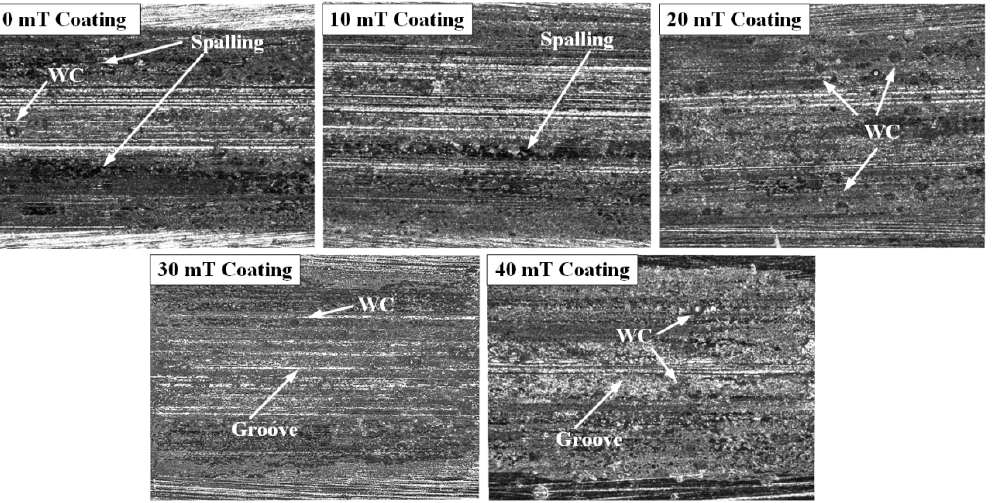
Figure 6. The wear morphology of the coatings.